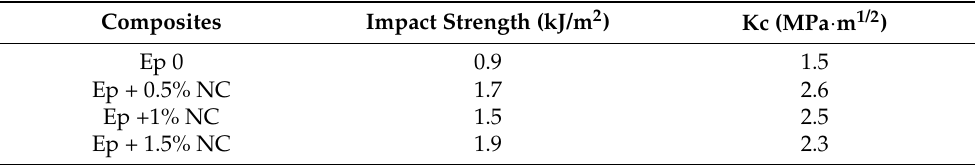
Table 4. Results of impact tests and values of critical stress intensity factor calculation.